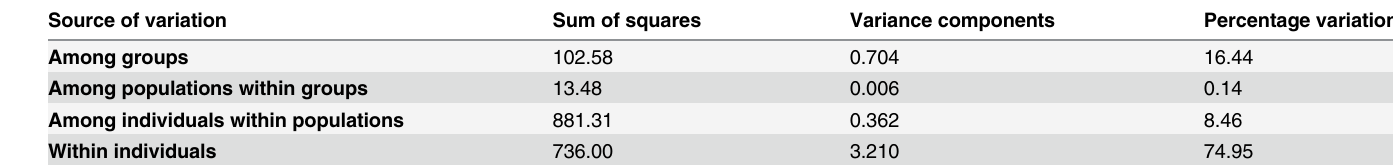
Table 3. Analysis of Molecular Variance (AMOVA) of genetic variation of yellowfin tuna from five locations.